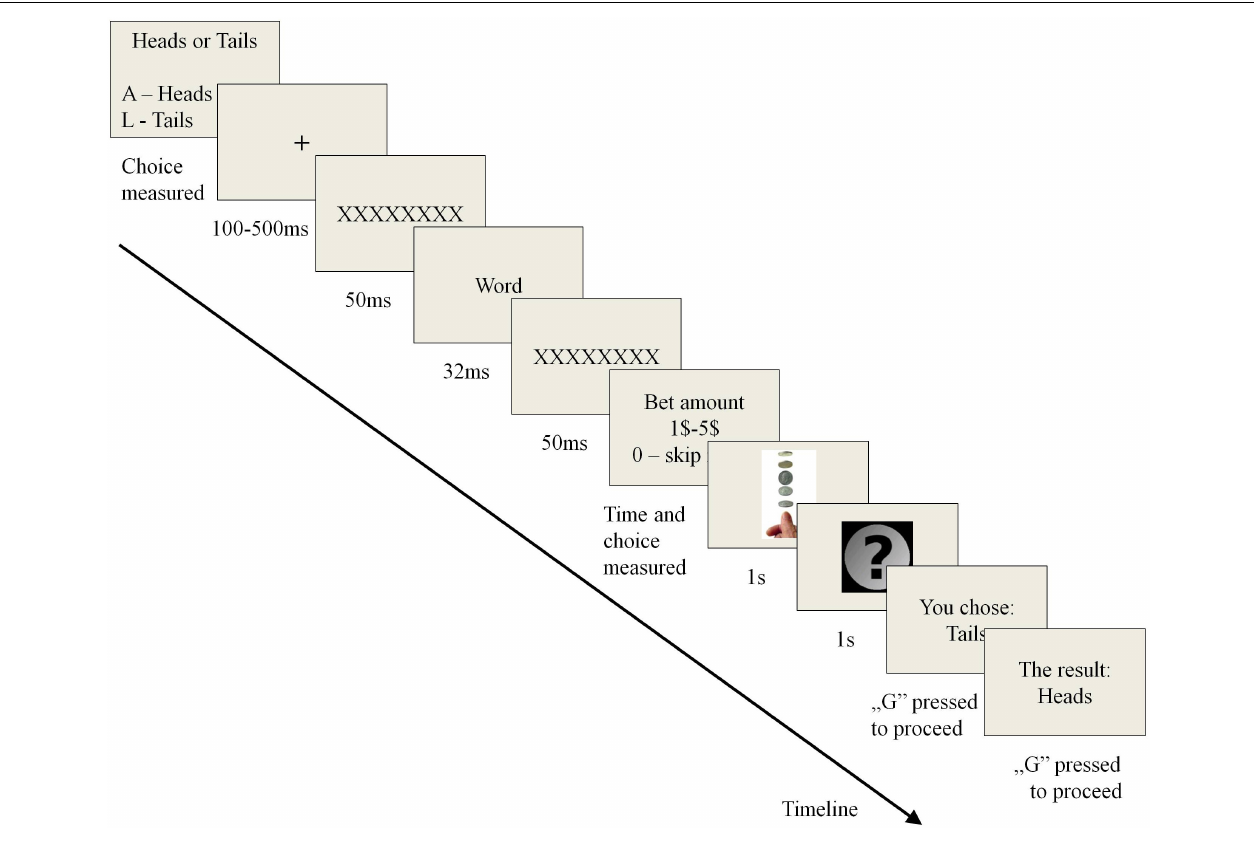
FIGURE 1 | Single trial of “Coin Toss” task (includes priming and decision on bet amount).